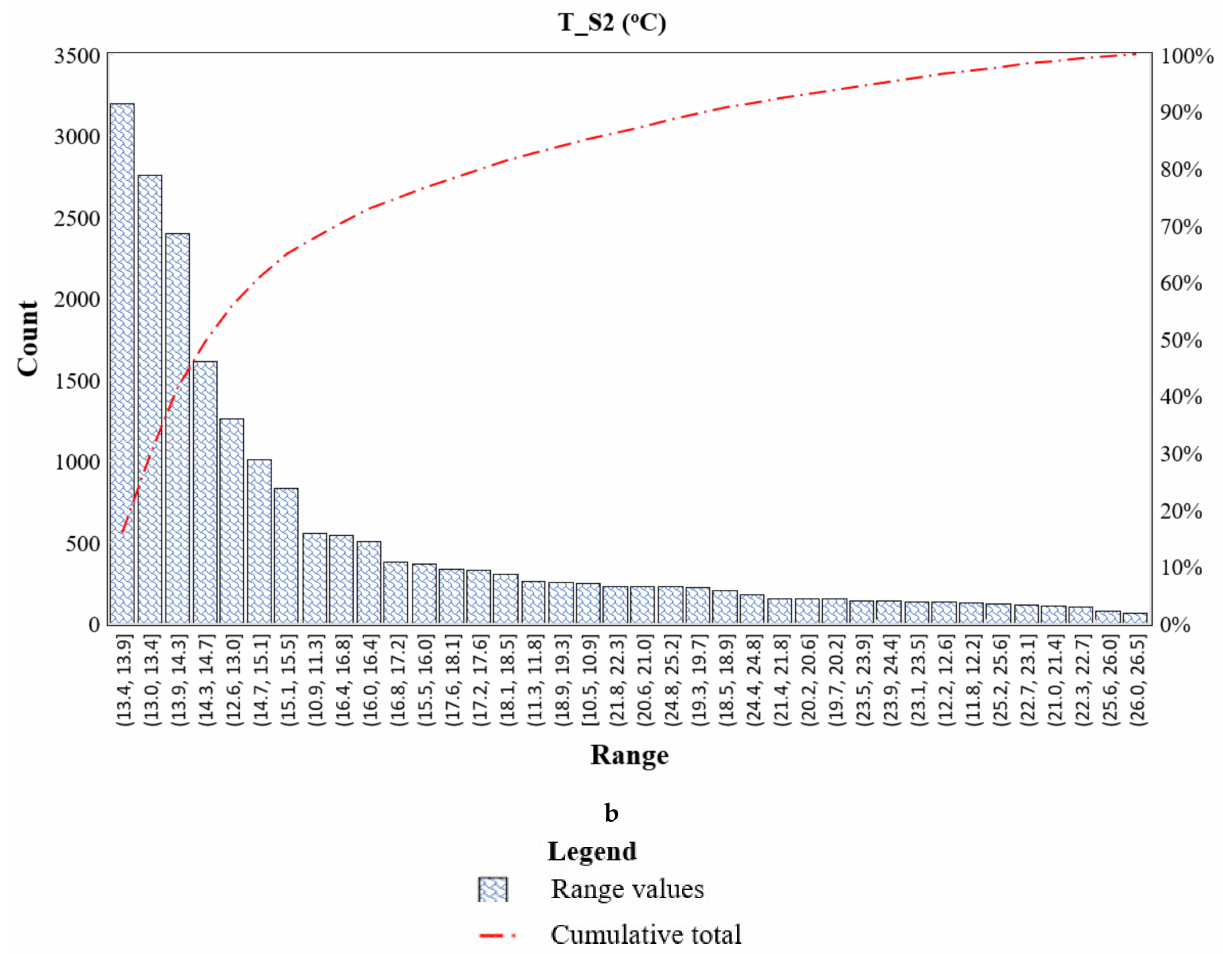
Figure 9. Pareto chart showing North ( a ) and South ( b ) temperature data spread of the MSG’s sensors. The data spread for RH and VPD were considered only for N1 (Figure 10) because it falls within the N-zone. With the minimum and maximum RH being 39.60% and 82.00%, respectively, 38.70% of the data was within the range 75–82% of RH, and 54.66% was within the range 60–75% RH. However, [4,6] recommended an optimum RH range of 60–75%. In this case, 94.15% of the VPD data were within the recommended value of 0.2–1.2 kPa for strawberry, whereas 54.05% was below 0.5 kPa [4,5]. These results show an optimum condition at the point despite 32.92% of the temperature data failing within the temperature setpoint. Contrary to the result in the SLG and DLG, where all data falling within the setpoints resulted in the VPD being outside the optimum range, approximately 33% of the temperature data in MSG falling within the setpoints resulted in the majority of the VPD data falling within the optimum range. The implication of this is that it will be beneficial for the crop if VPD is used as a setpoint rather than the